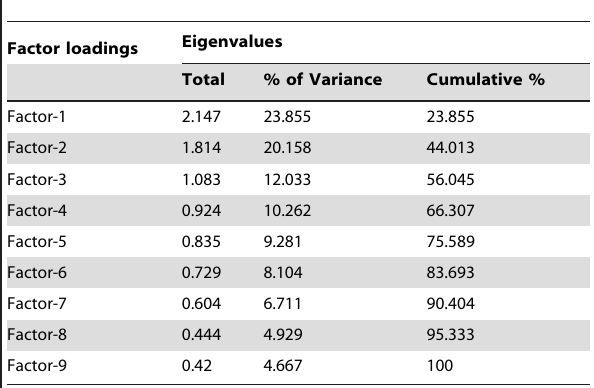
Table 3. Eigenvalues for principal component analysis (PCA). Table 4. Varimax rotation component matrix of principal component analysis.